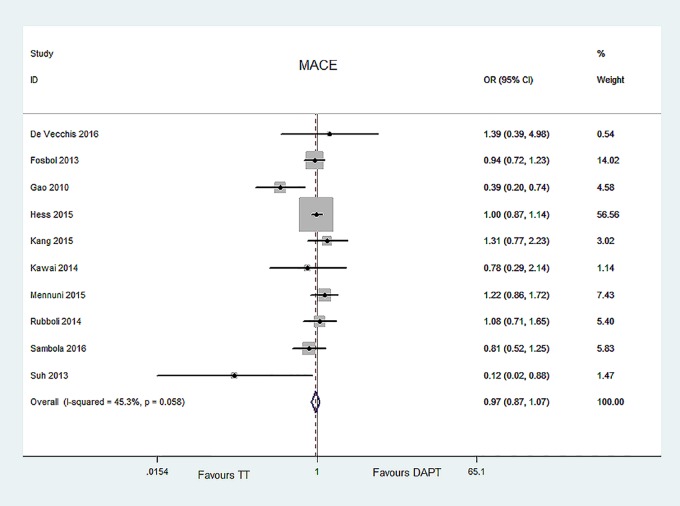
Forest plot of MACE in TT group and DAPT group.